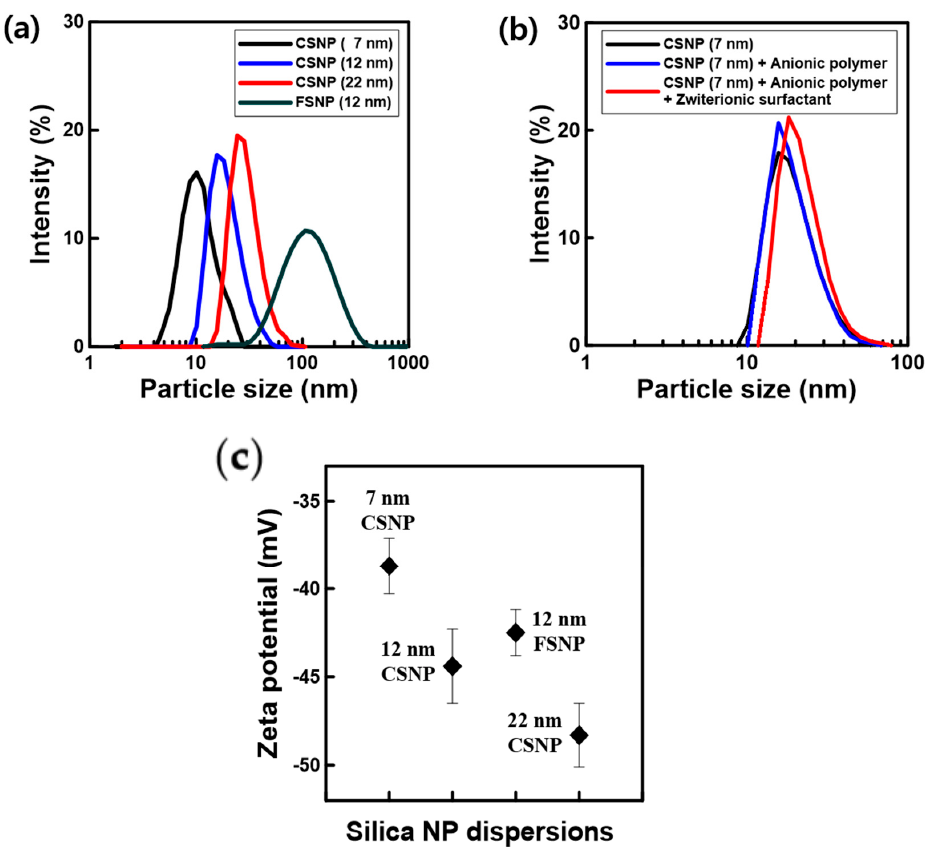
Figure 3. ( a ) DLS analysis of differently sized silica NPs, ( b ) DLS analysis of 7 nm with anionic polymer and zwitterionic surfactant, and ( c ) zeta potential analysis of differently sized silica NPs in colloidal dispersions.